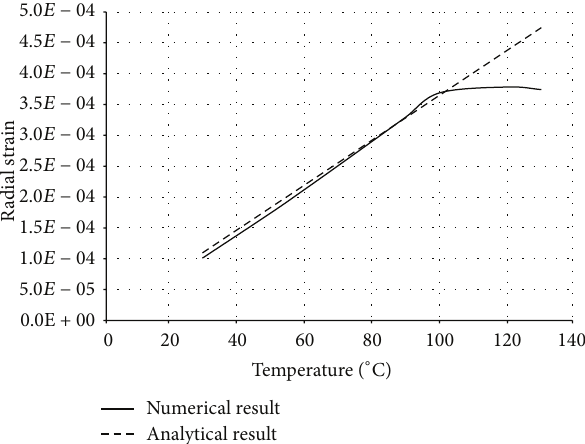
Figure 15: Comparison of radial strain in steel